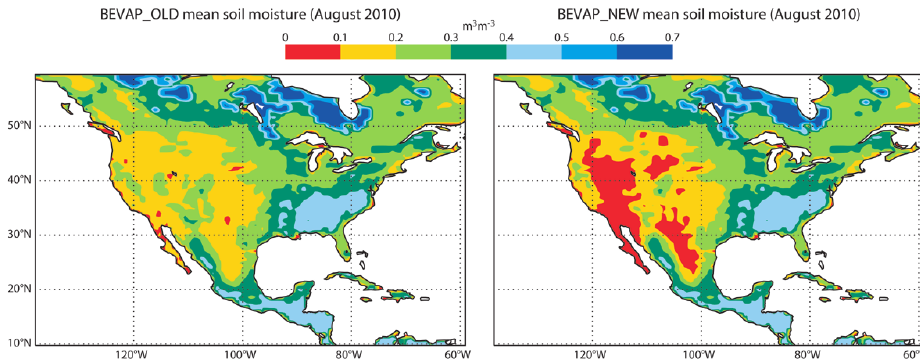
Fig. 2. Mean soil moisture for BEVAP OLD (left) and BEVAP NEW (right) (August 2010). Table 2. Statistical scores for the comparison between ECMWF surface soil moisture (offline experiments, BEVAP OLD and BEVAP NEW) and in situ data for all the stations from the NRCS-SCAN (USA) network over the 2010 period. Soil Moisture Anomaly Bias RMSD data set N stations R R (m 3 m − 3 ) (m 3 m − 3 ) ECMWF BEVAP OLD 122 0.60 0.54 − 0.095 0.135 [control experiment] ECMWF BEVAP NEW 122 0.62 0.55 − 0.064 [test]